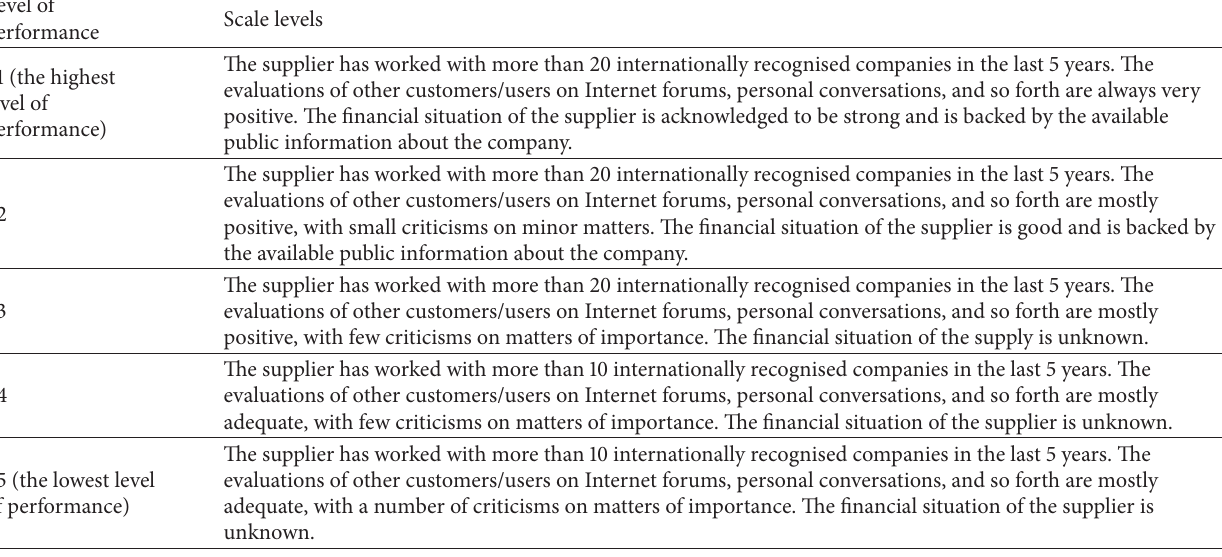
Table 2: Scale levels of descriptor associated with the criterion